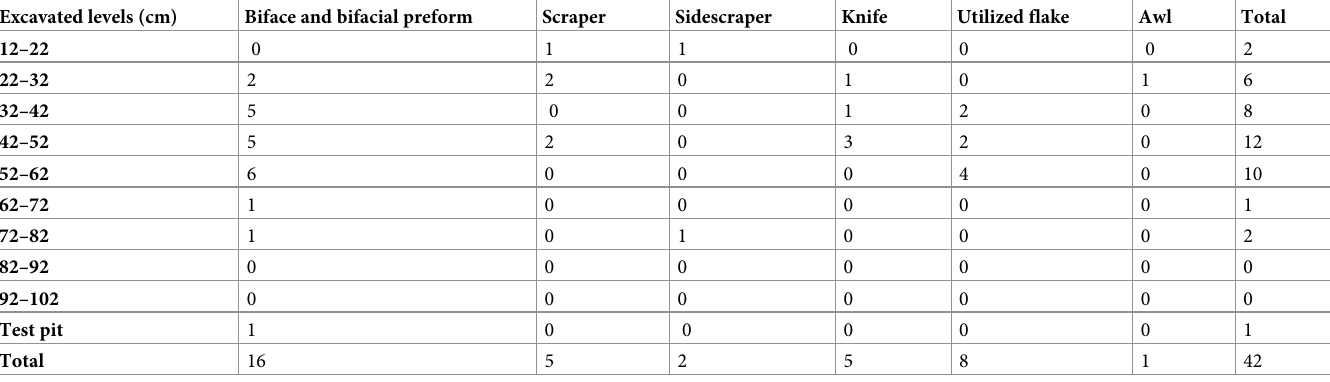
Table 4. Flake classes represented in the lithic assemblage. Excavated levels